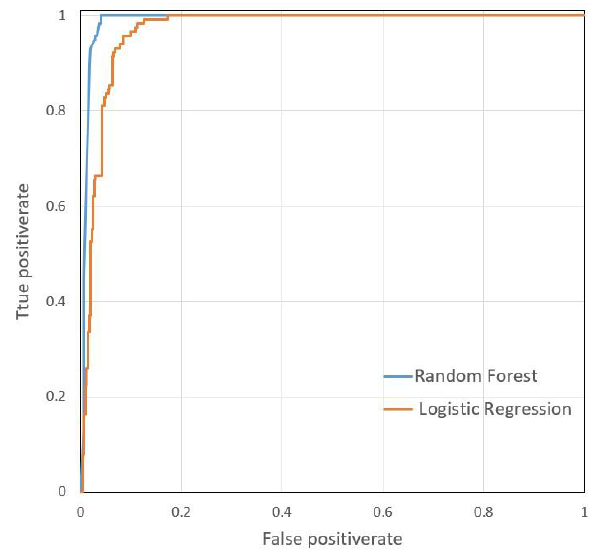
Figure 9. Comparison of ROC curves.